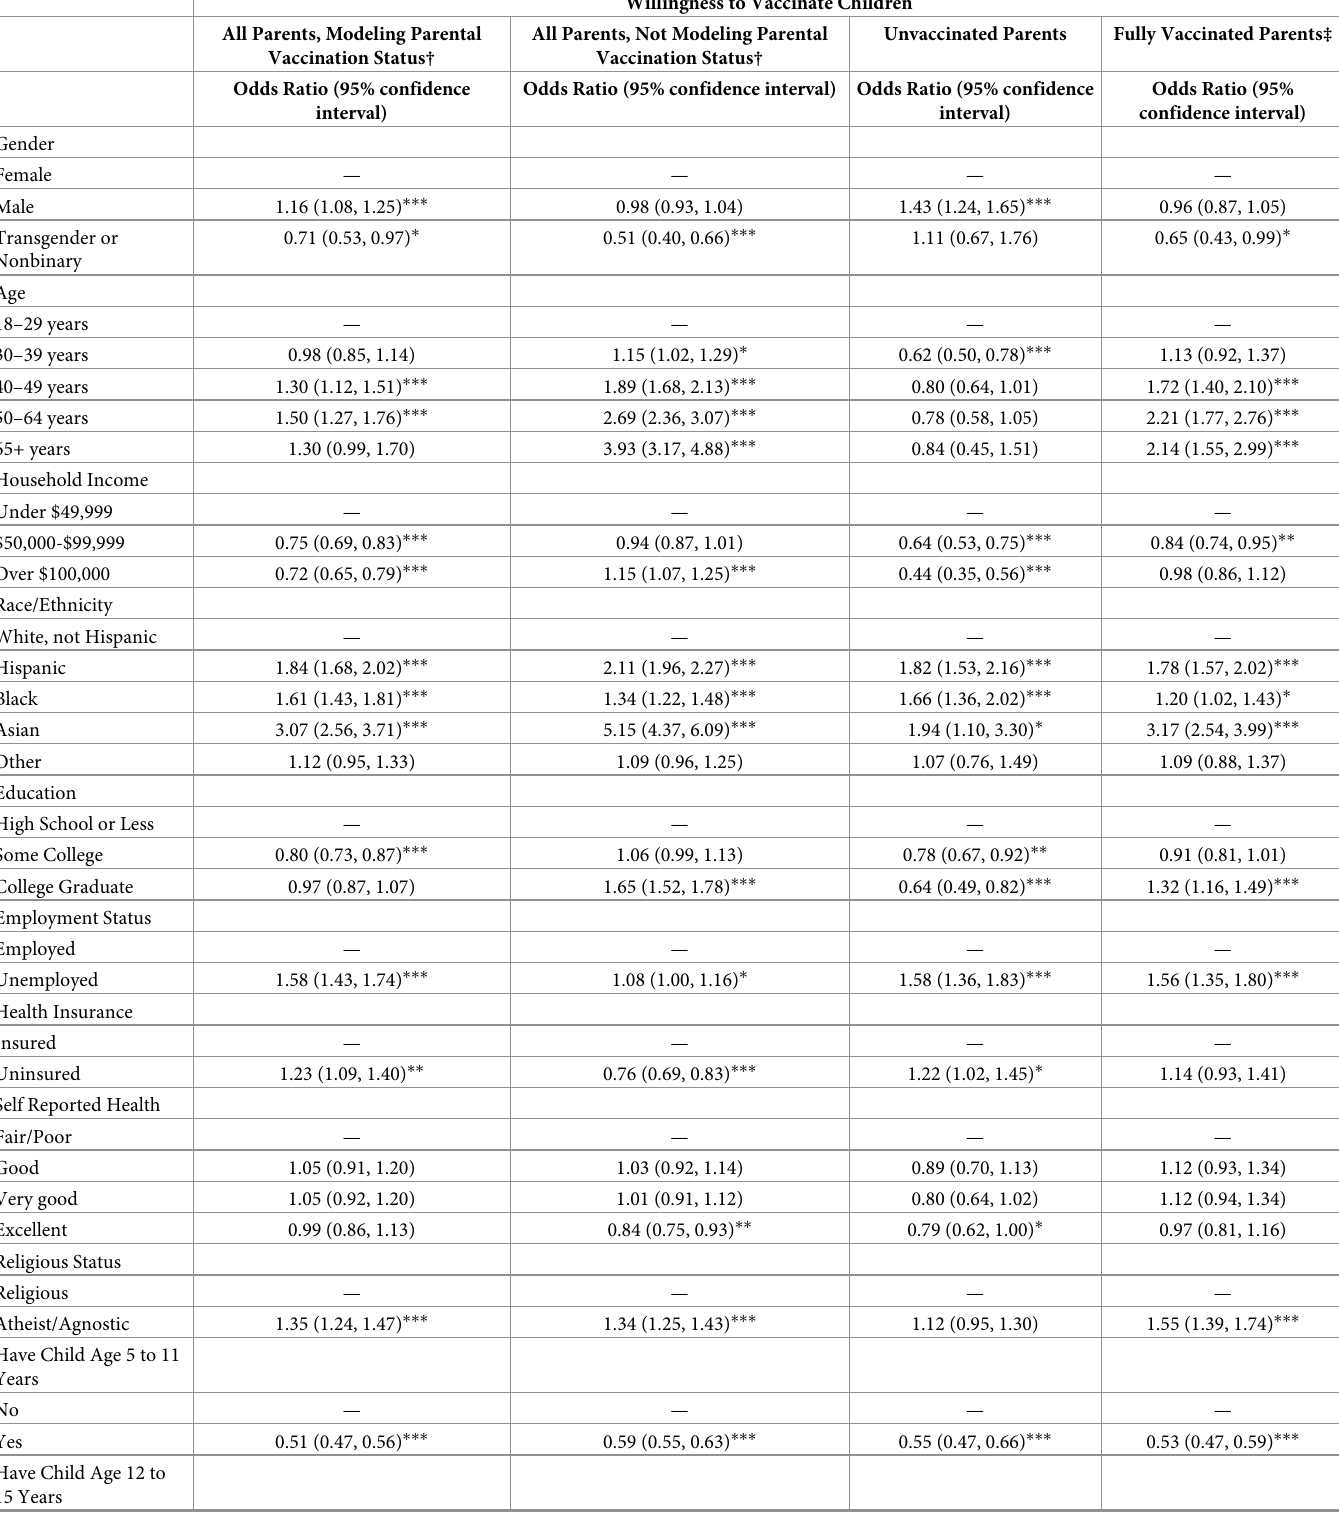
Table 2. Multivariate relationship between parent characteristics and willingness to vaccinate